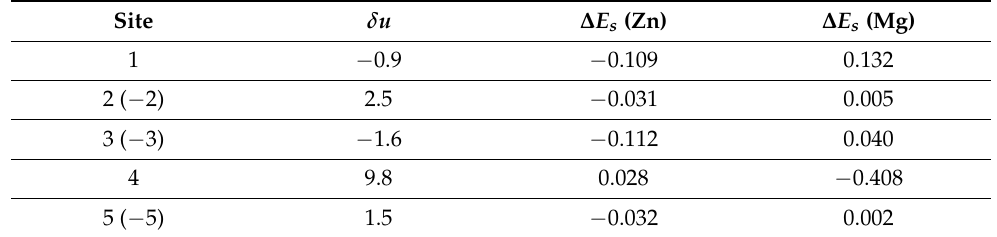
Table 1. Segregation energy ∆ E s (eV) of Zn and Mg solutes and local lattice deformation δ u (%) in different positions on the Σ 5(013) <100> GB in